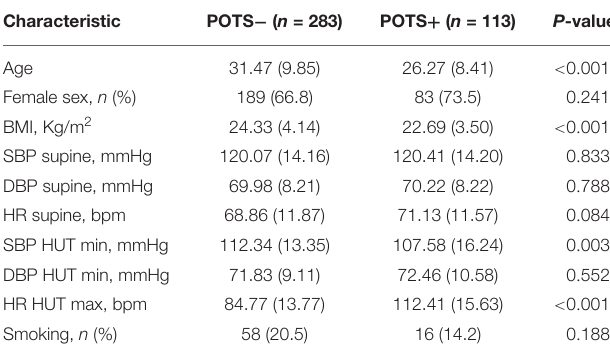
TABLE 1 | Baseline characteristics of the study